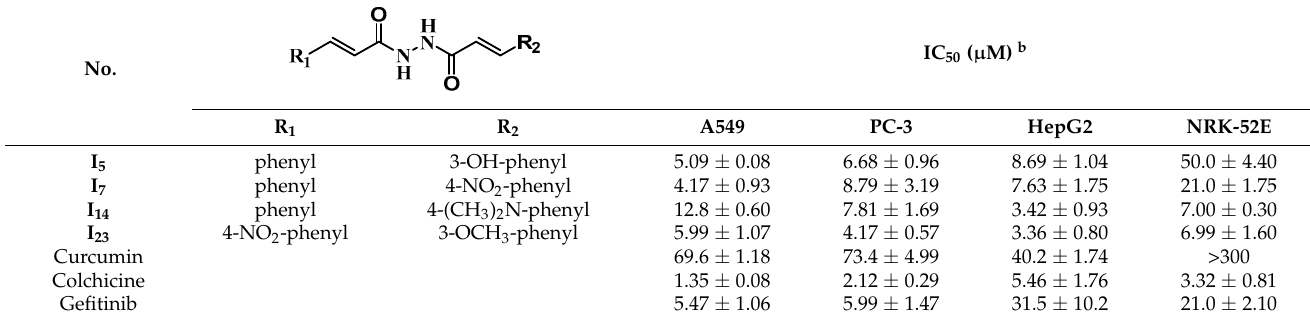
Table 2. Cytotoxicity and selectivity of title compounds I 5 , I 7 , I 14 and I 23 a .